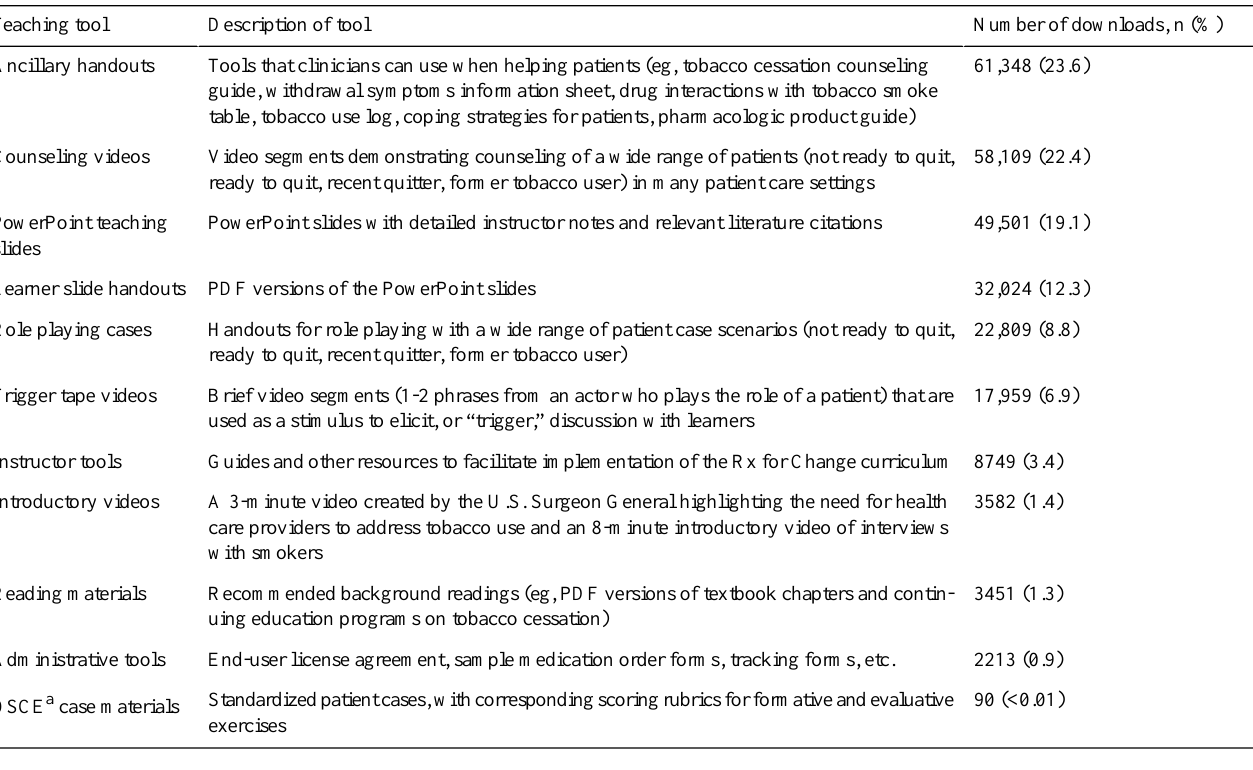
Number of downloads, n (%)Description of toolTeaching tool